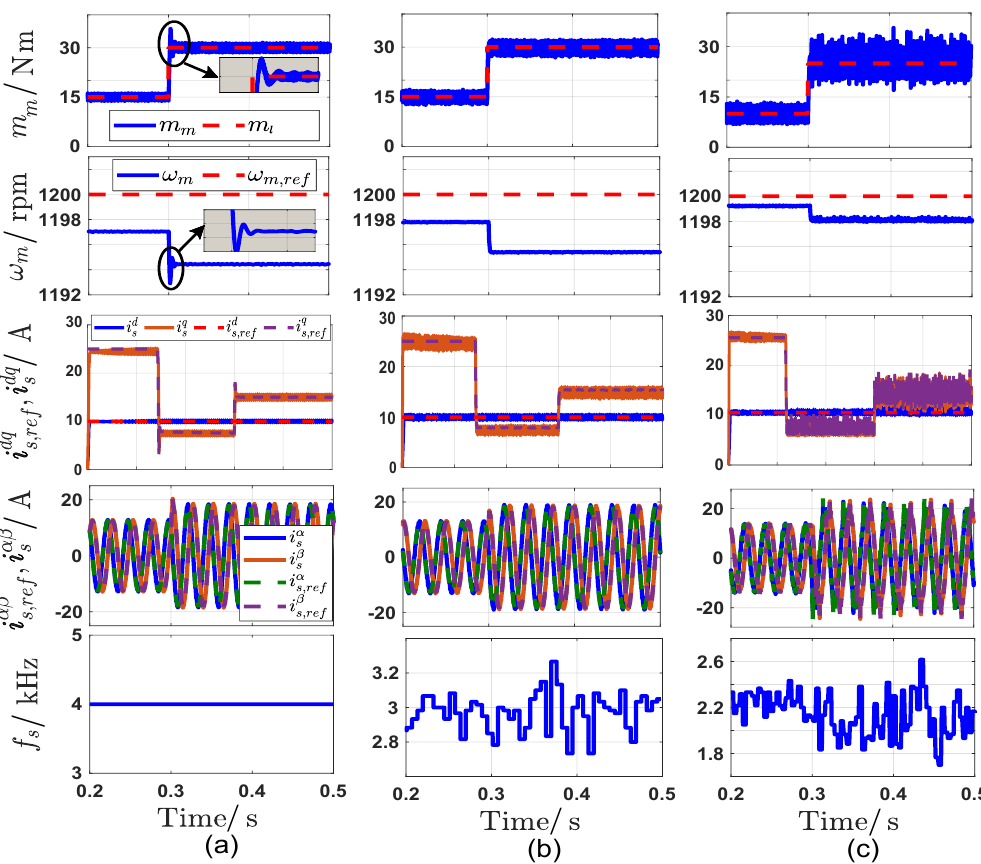
Figure 15. Overall performance of the different control strategies under a step change of mechanical load torque under speed of 1200 rpm: ( a ) FOC, ( b ) CPC, and ( c ) Proposed